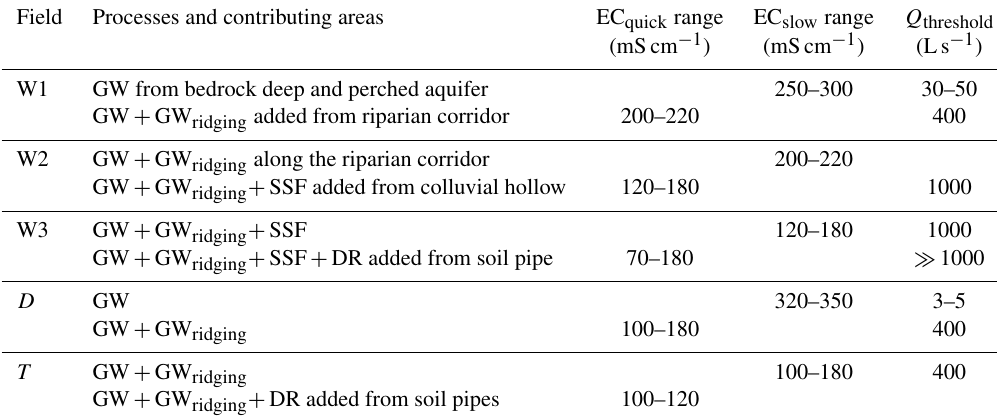
Table 3. Hydro-chemical parameter range, distinctive for the wet ( W ), dry ( D ) and transition ( T ) period events. Legend: GW is for ground- water, SSF is for subsurface flow, and DR is the direct runoff (modified from Guida and Cuomo,